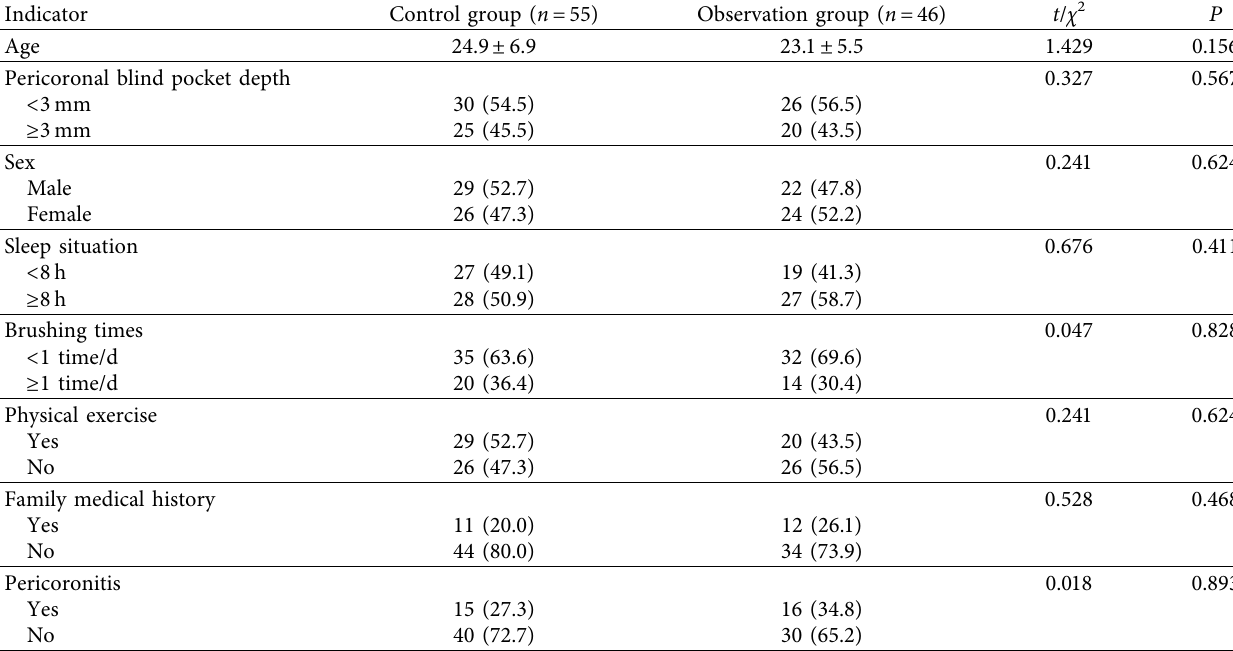
Table 2: Comparison of clinical